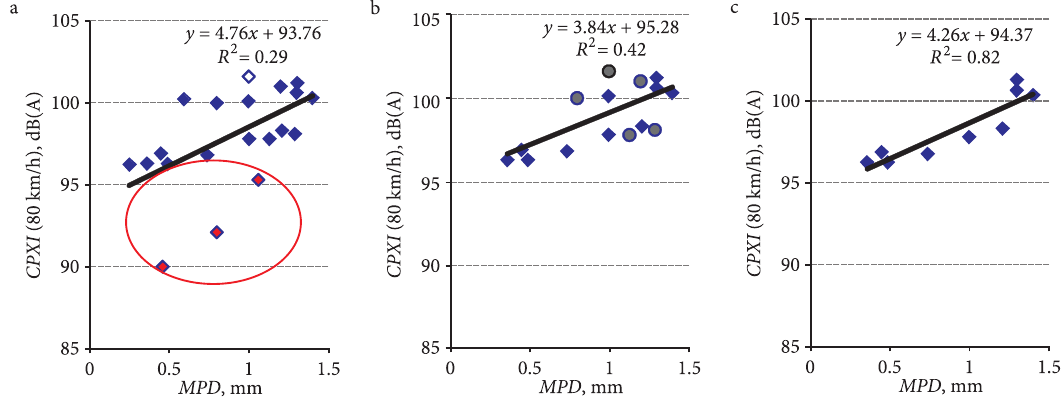
Fig. 1. Noise level as a function of macrotexture: a – tested pavements (porous pavements distinguished); b – tested pavements without porous asphalt pavements; c – dense asphalt concrete